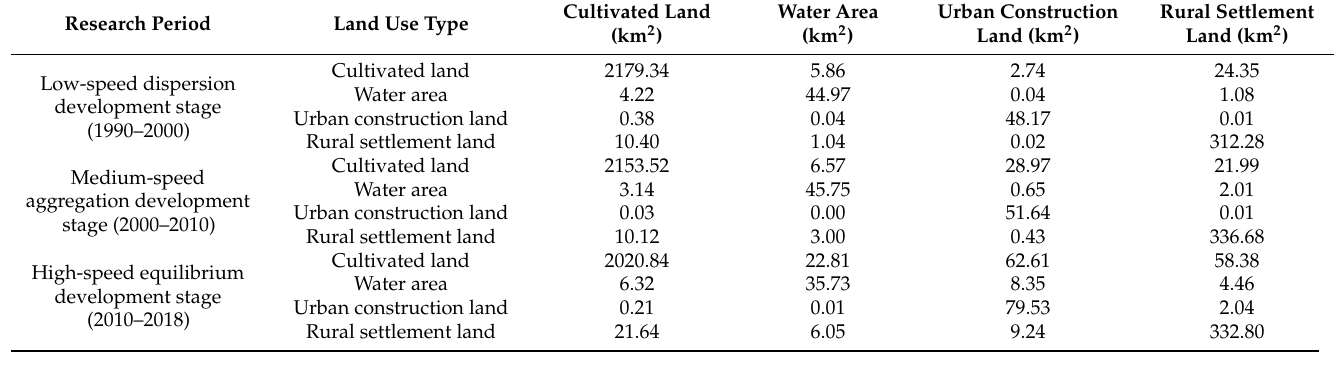
Table 2. Land use transition matrix at different stages.